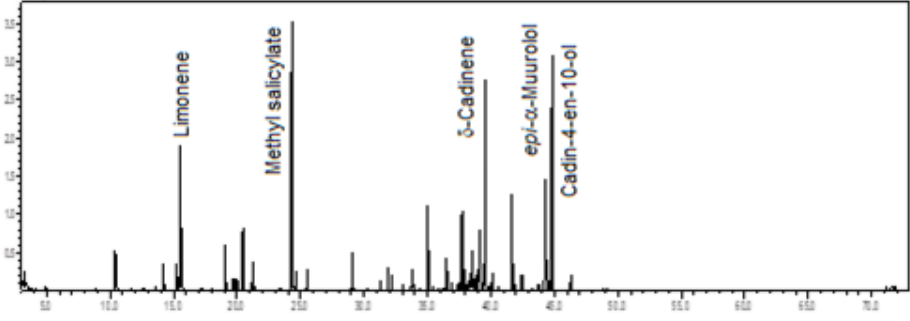
Figure 12. Ion-chromatogram of the Catasetum gnomus volatile concentrate.